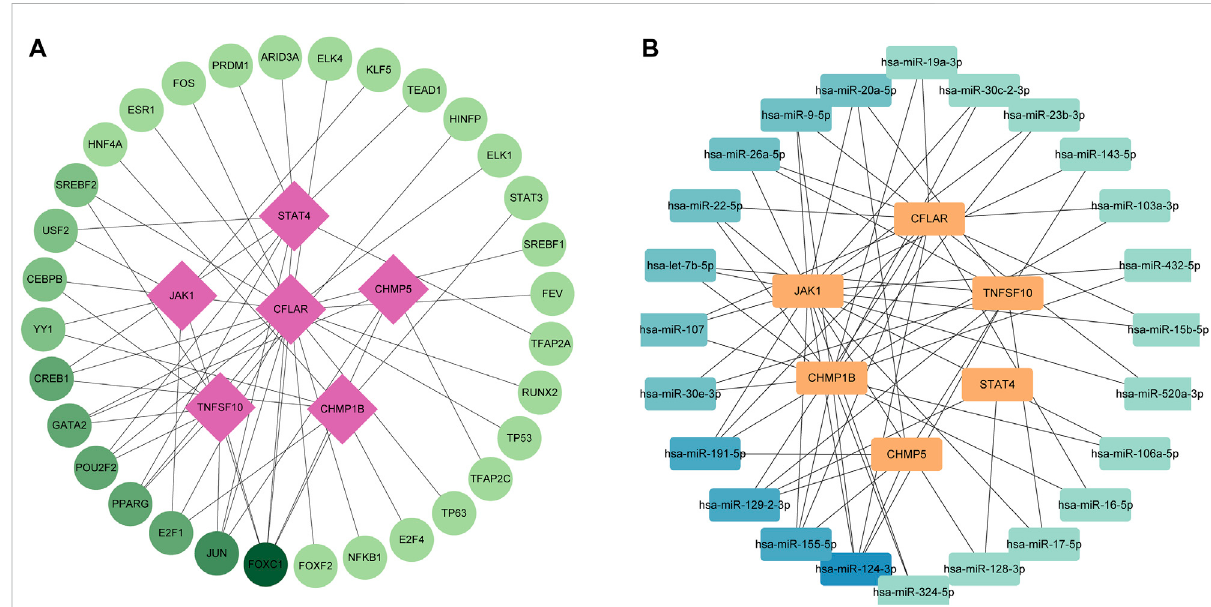
FIGURE 3 (A) Transcription factor-necroptosis-related differentially expressed genes (NRDEGs) regulatory network in ICM. The red squares represent NRDEGs, and the green dots represent transcription factors. The color of the edge lines in this network represents the correlation. (B) MiRNA- NRDEGsregulatorynetworkinICM.TheyellowsquaresrepresentNRDEGs,andthebluesquaresrepresentmiRNA.Thecoloroftheedgelinesinthis network represents the